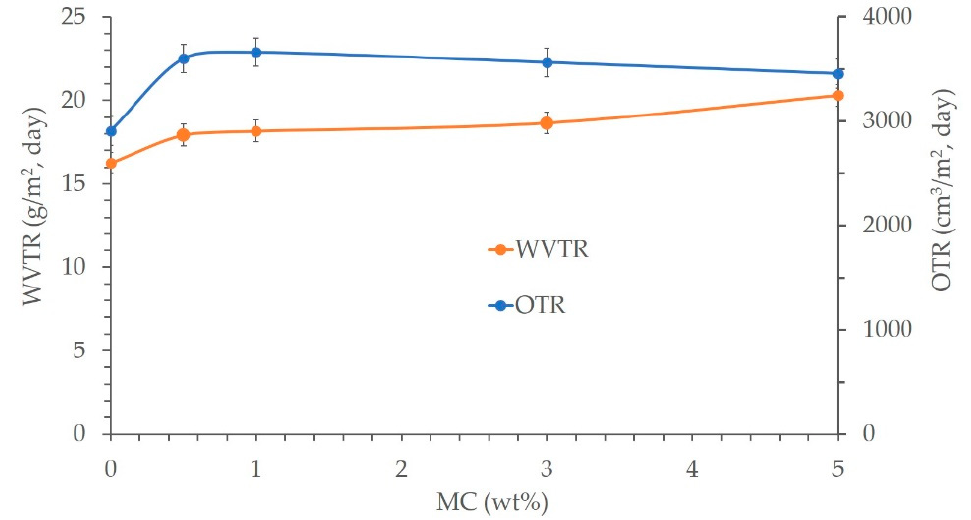
Figure 7. The oxygen transmission rate (OTR) and water vapor transmission rate (WVTR) as the barrier properties of various LDPE/MC composite films.